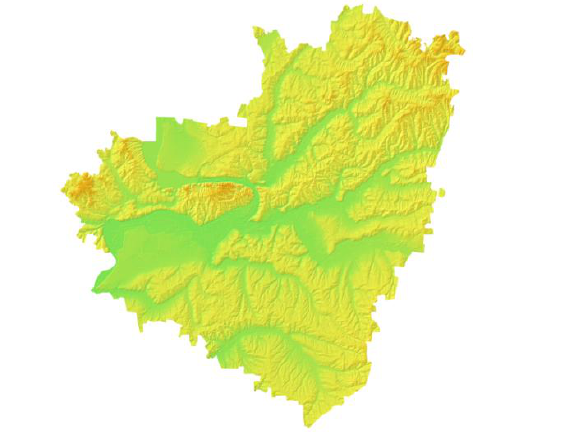
Figure 4. Overlay layers with transparency setting